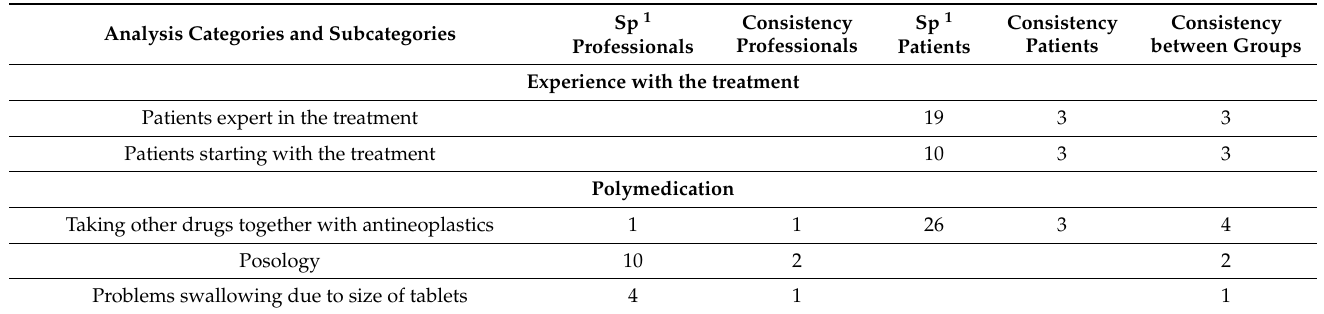
Table 3. Cross-validation. Consistency between patient and professional